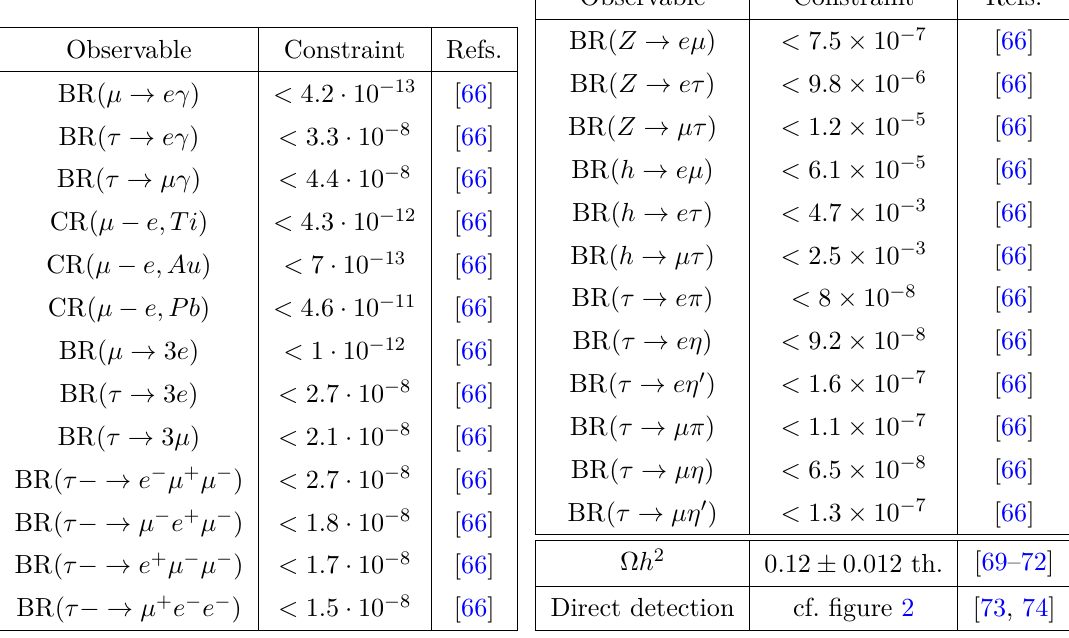
Table 4 . Leptonic flavour and dark matter constraints. These upper limits numbers are given at the 90% confidence level. For the dark matter relic density we assume 10% theoretical uncertainties because of cosmological